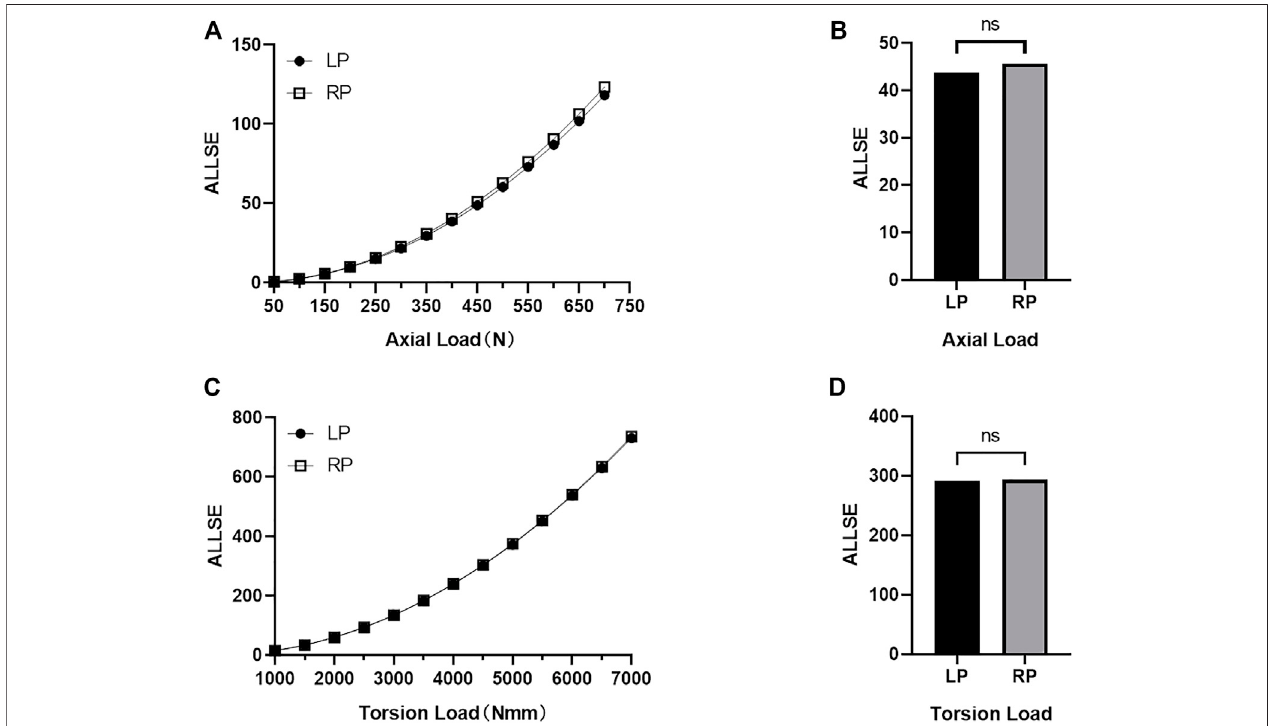
FIGURE 3 | The strain energy (ALLSE) of whole the LP and RP construct changes with the load under axial compression load conditions and torsional load conditions. (A) Change in ALLSE in the LP and RP constructs under different axial compression load values (B) Statistical analyses of ALLSE for the LP and RP constructs under all axial compression load values ( p > 0.05) (C) Change in ALLSE in the LP and RP constructs under different torsional load values (D) Statistical analyses of ALLSE for the LP and RP constructs under all torsion load values ( p >